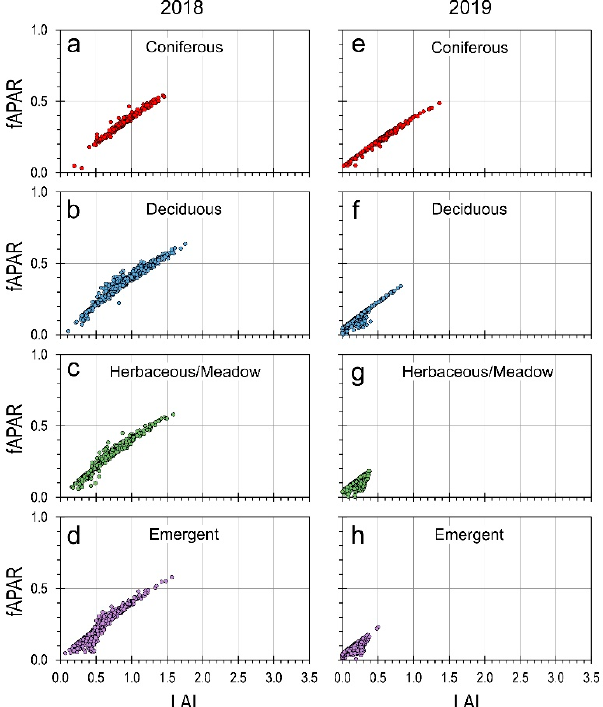
Figure 13. May comparison of absorbed photosynthetically available radiation (fAPAR) vs. emergent leaf area index (LAI) for the 2018 ( a – d ) and 2019 ( e – h ) for the Coniferous, Deciduous, Herba- ceous/Meadow and Emergent classes.